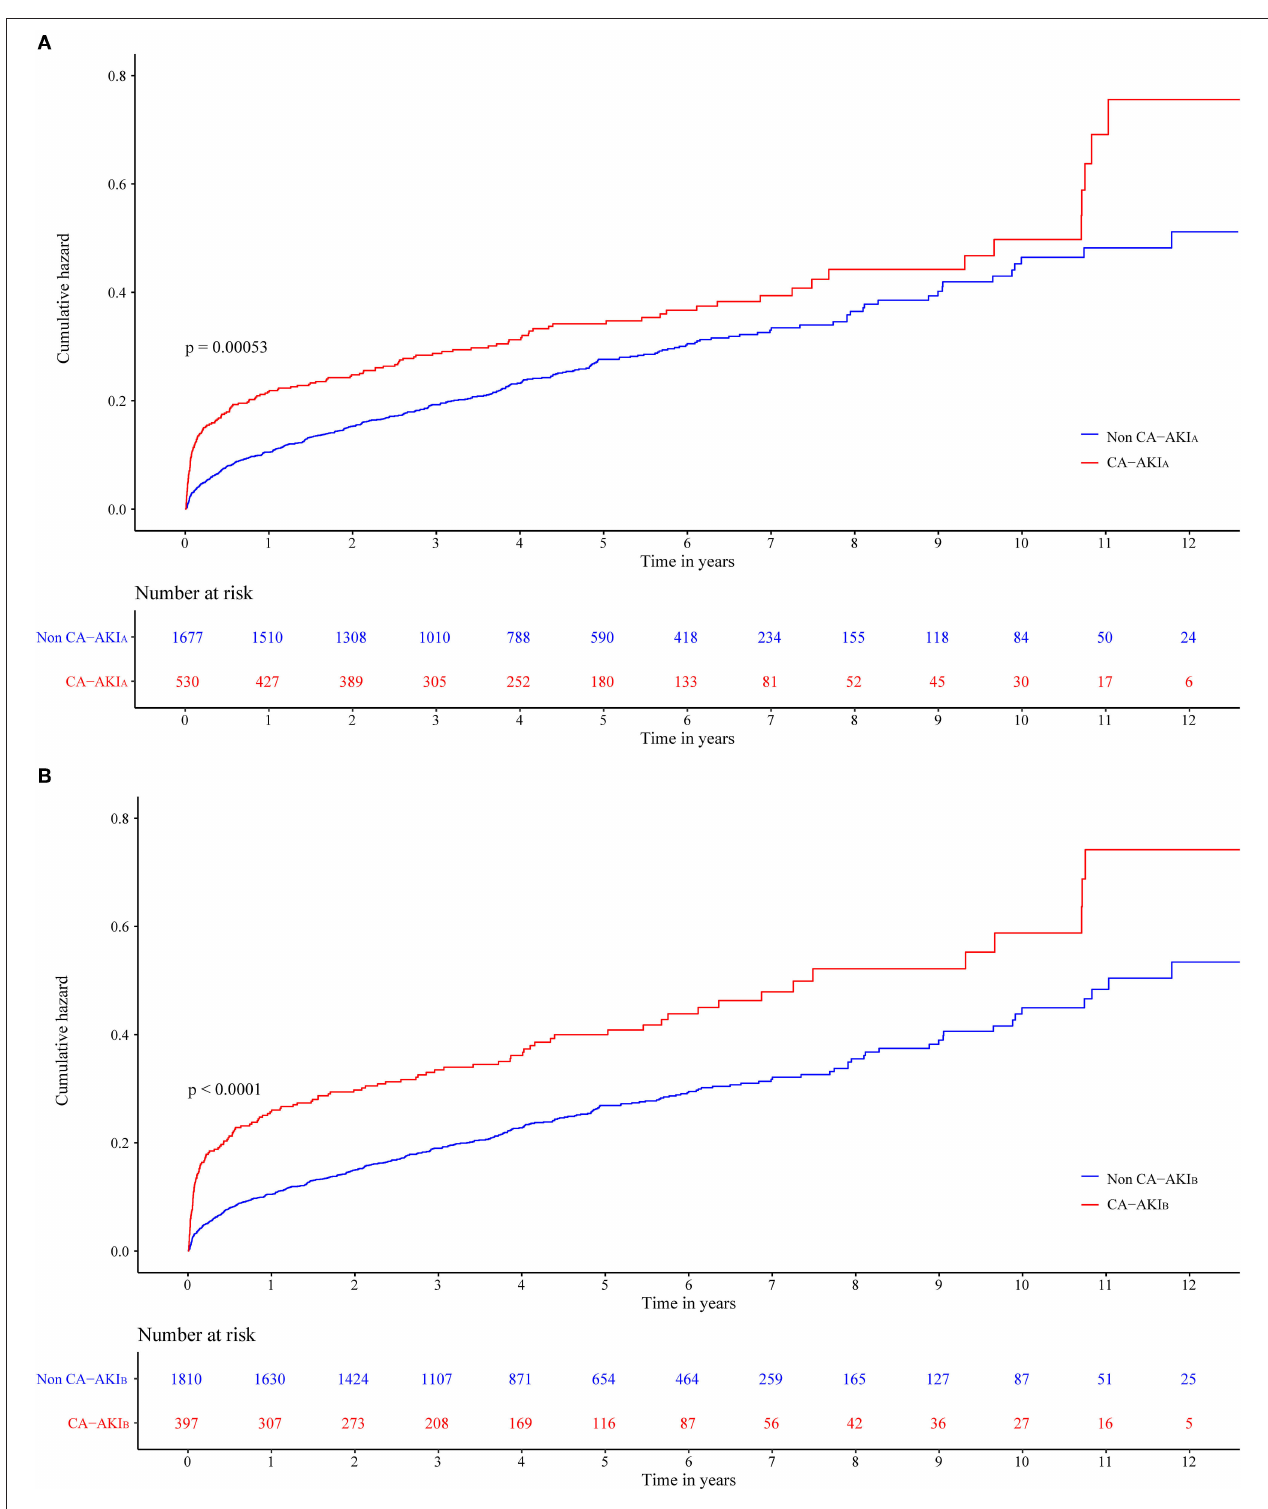
FIGURE 2 | Cumulative incidence of all-cause death for two different contrast-associated acute kidney injury (CA-AKI) definitions patients with congestive heart failure (CHF). (A) Definition of CA-AKI A . (B) Definition of CA-AKI B .